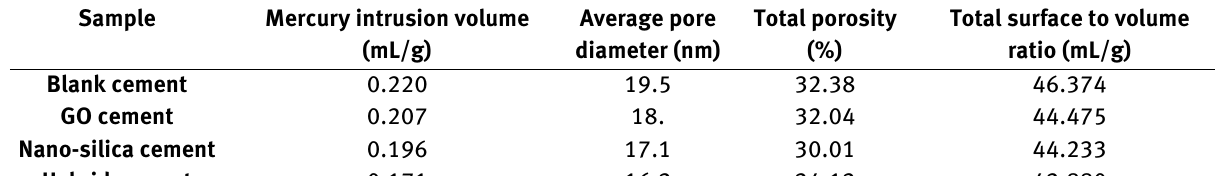
Table 2: Pore structure parameters of different samples [17]